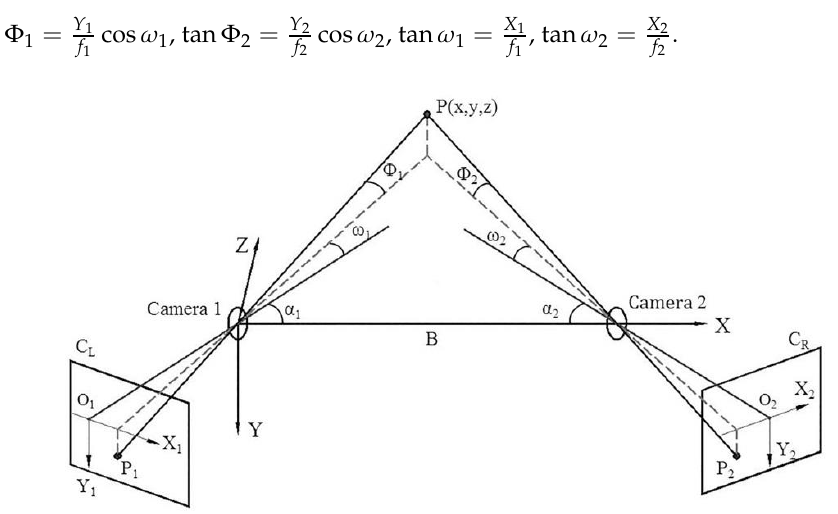
Figure 3. The monitoring model of binocular vision measurement.